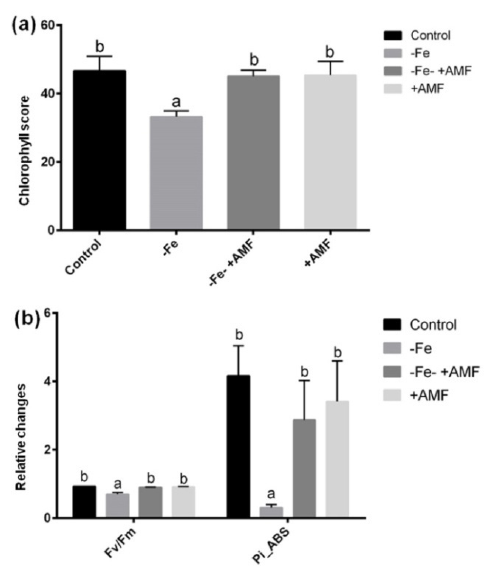
Figure 3. E ff ects of Fe deficiency and AMF on alfalfa photosynthetic indices. ( a ) Regulation of chlorophyll score, ( b ) Fv / Fm (quantum e ffi ciency of photosystem II), and Pi_ABS (photosynthesis performance index) under Fe deficiency with or without AMF. Data represent means ± SD ( n = 3). Di ff erent letters indicate significant di ff erence at p < 0.05 level. Table 1. ICP-MS analysis of elemental concentration (mg · g − 1 DW) in root and shoot of alfalfa cultivated under Fe deficiency (-Fe) with or without AMF. Data represent means ± SD ( n = 3). Di ff erent letters above the tabulated values indicate significant di ff erence at p < 0.05